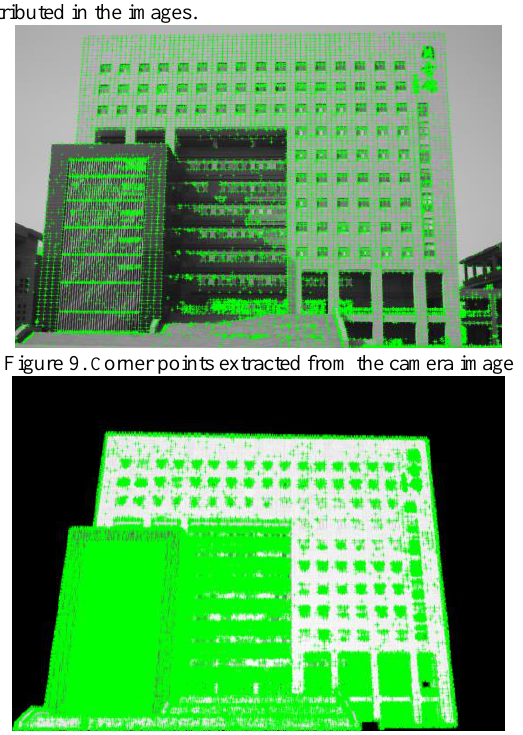
Figure 10. Corner points extracted from the intensity image